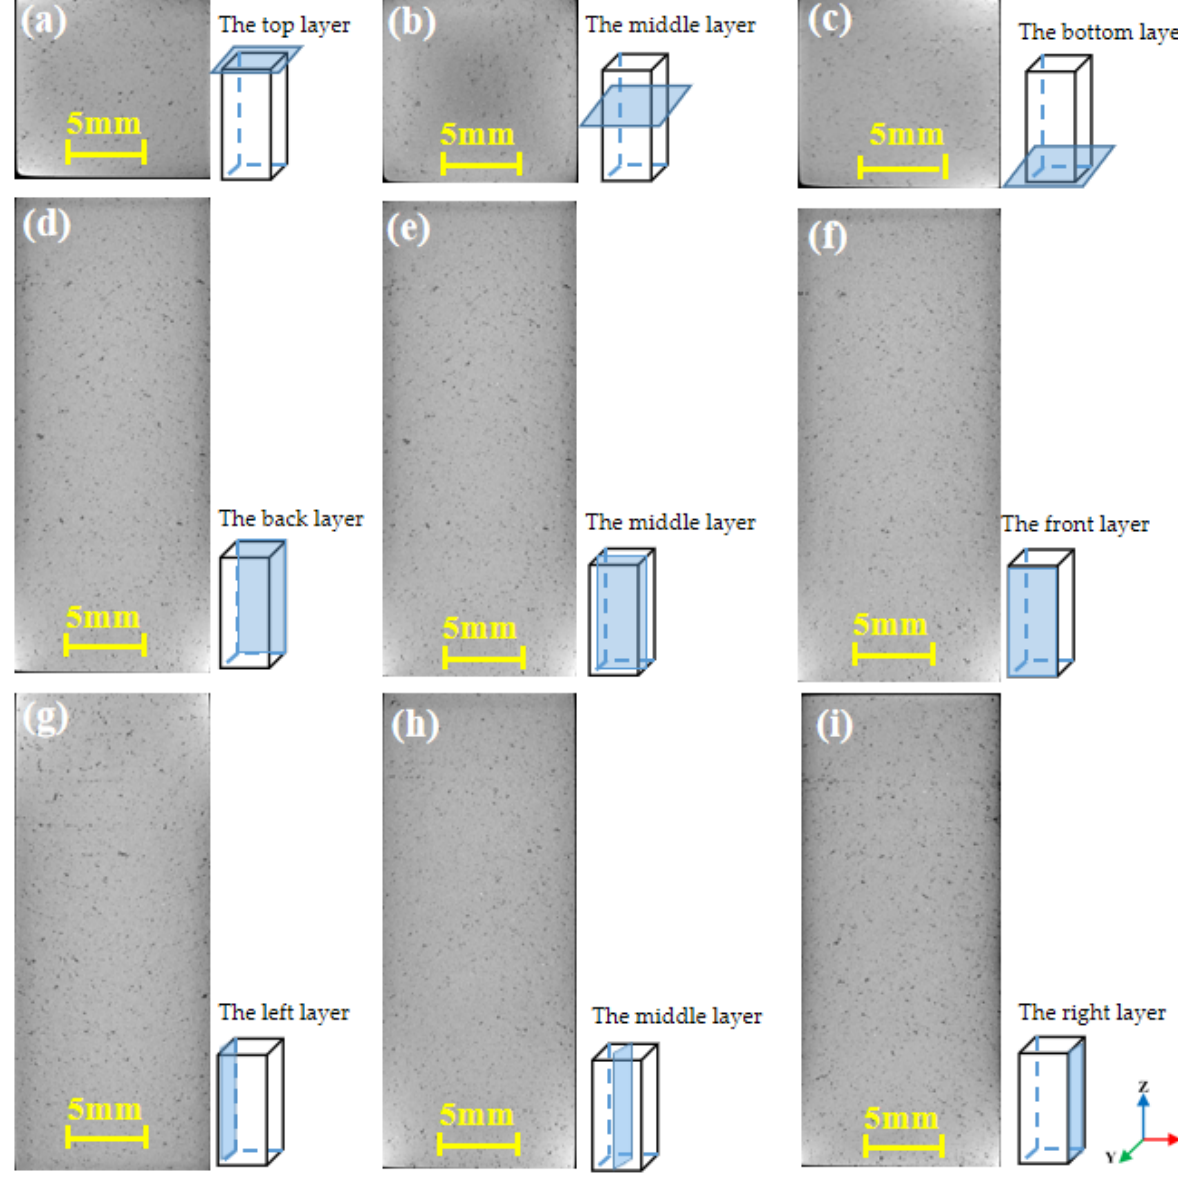
Figure 11. Image from inside to outside layer of plane obtained via XCT analysis in sample 2. ( a ) Top plane in XOY; ( b ) middle plane in XOY; ( c ) bottom plane in XOY; ( d ) back plane in YOZ; ( e ) middle plane in YOZ; ( f ) front plane in YOZ; ( g ) left side plane in XOZ; ( h ) middle plane in XOZ; ( i ) right outermost side plane in XOZ. Figure 11a–c represents the top, middle and bottom layer in XOY, respectively. As shown, the top and bottom layers contain more holes than the middle layer. This is because the middle layer possessed heat transferred from both upper and lower layers, which results in a low quantity of pore defects. For the bottom layer, the amount of heat was insufficient for an effective bonding between the layers. The top layer differed from the bottom layer which was in contact with the nitrogen in the forming cavity; therefore, the amount of waste heat was insufficient for the metal liquid to fuse and solidify, and rapid Bottom layer cooling resulted in an increased number of Top layer